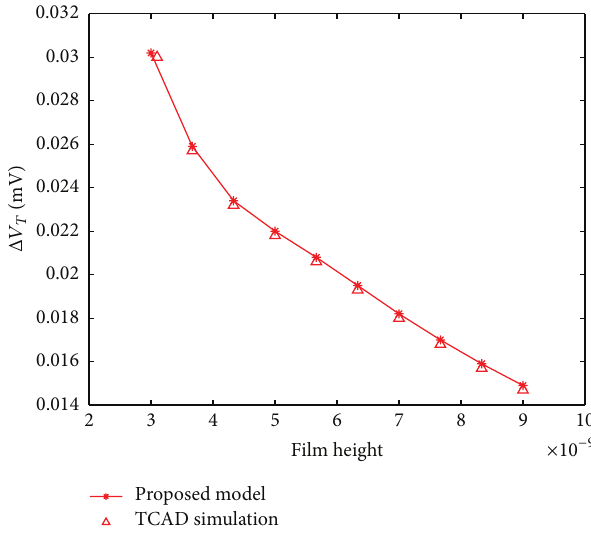
Figure6:Variationofthresholdvoltagewithfilmwidthfordifferent height at 𝐿 = 20 nm.